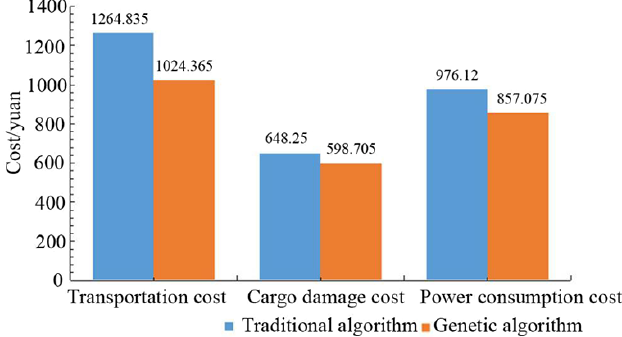
Fig. 3. Comparisons of costs of the two algorithms.